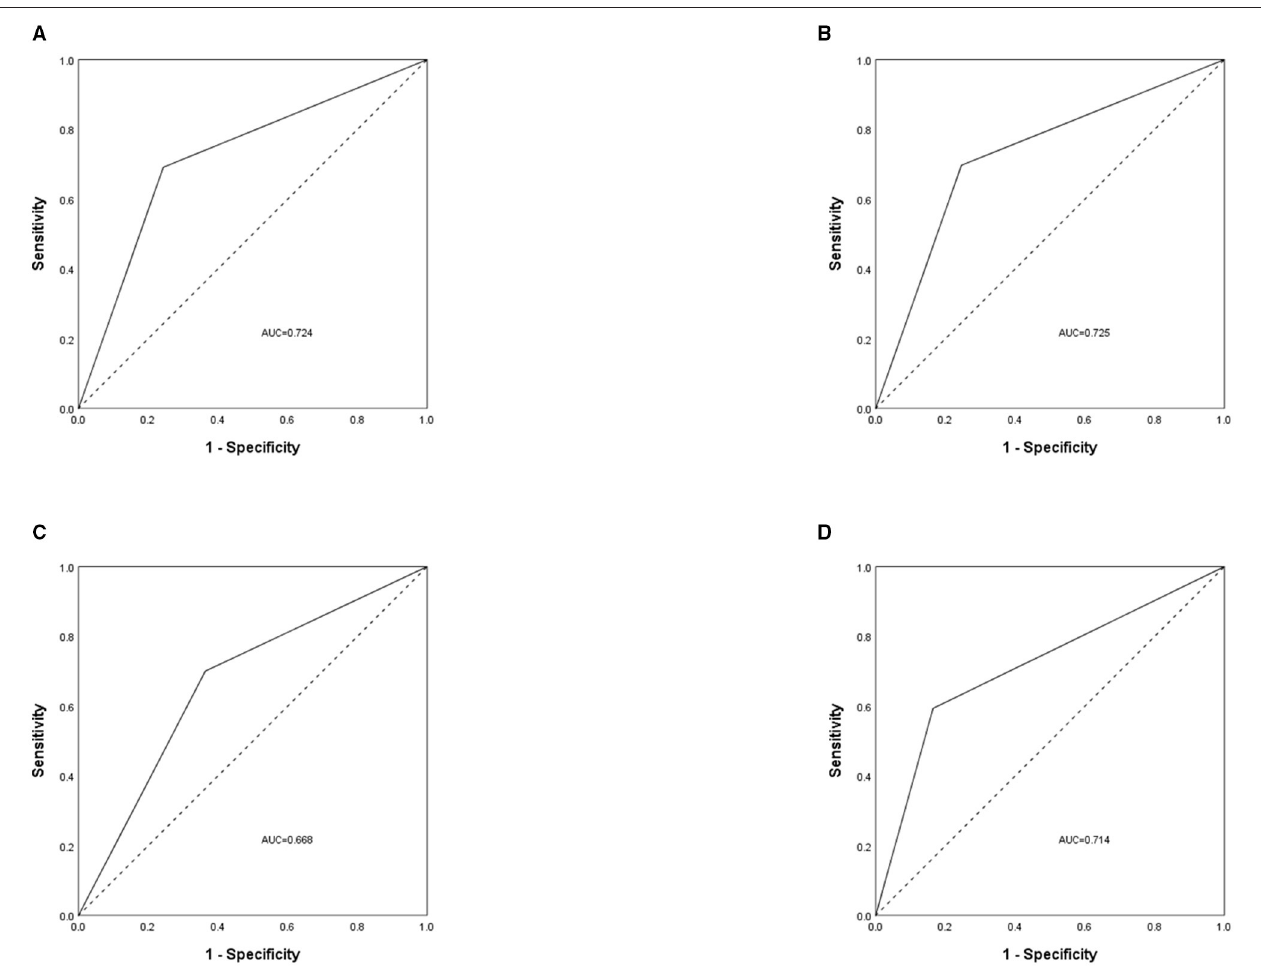
FIGURE 2 | The receiver operating characteristic (ROC) curve was used to assess the difference between patients with malnutrition and without malnutrition, measured by Global Leadership Initiative on Malnutrition (GLIM) criteria and subjective global assessment (SGA). The analysis was grouped by disease type, with (A) for all cancer patients, (B) for patients with colorectal cancer, (C) for patients with gastric cancer, and (D) for patients with lung cancer. AUC, area under the curve.